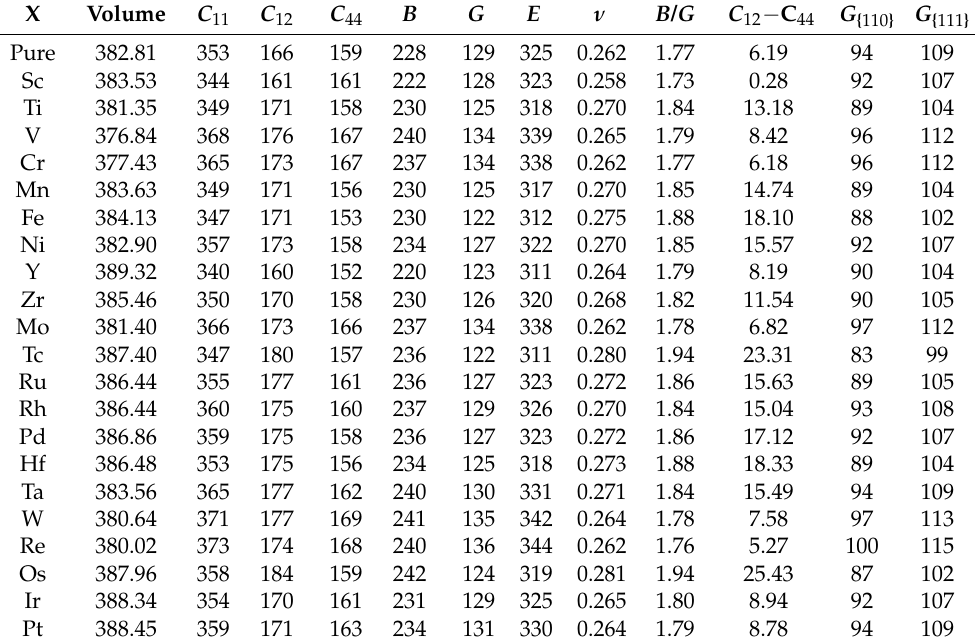
Table 2. Calculated equilibrium supercell volume (Å 3 ) and polycrystalline elastic properties (GPa) of X-substituted γ (cid:48) -Co 3 Nb compounds, including elastic constants ( C ij ), bulk modulus ( B ), shear modulus ( G ), Young’s modulus ( E ), Poisson’s ratio ( ν ), B/G ratio, C 12 − C 44 , G { 110 } and G { 111 }